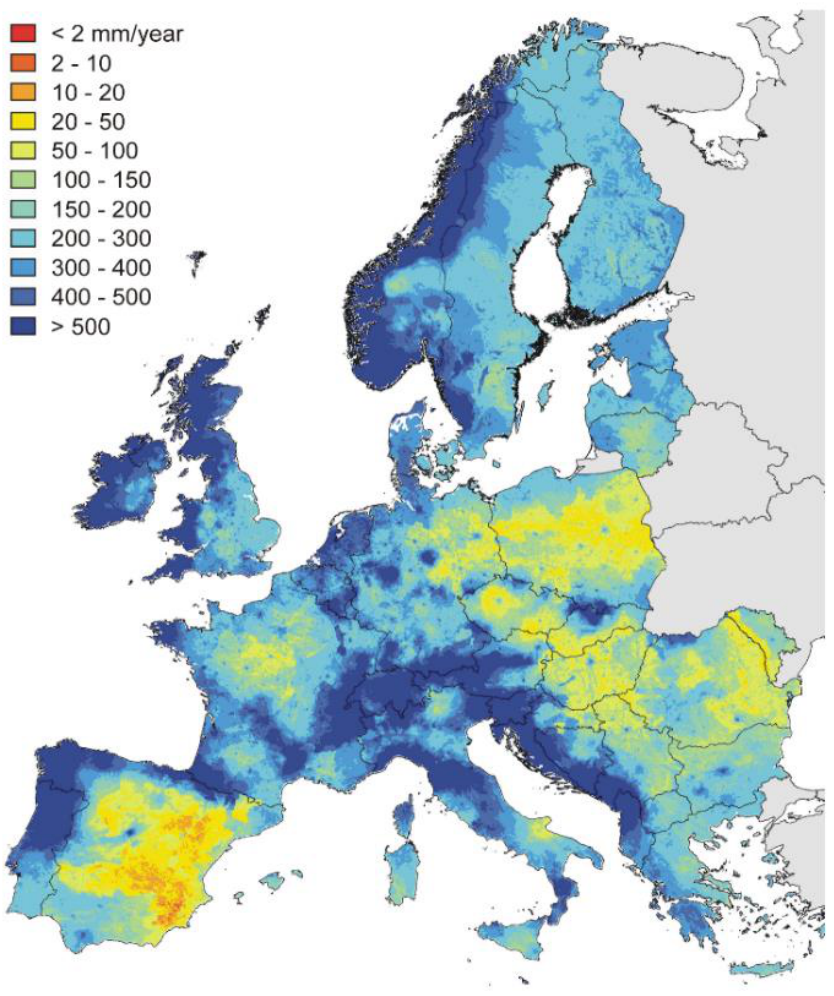
Figure 1. Annual fresh water availability for Europe (average for 1990–2010)